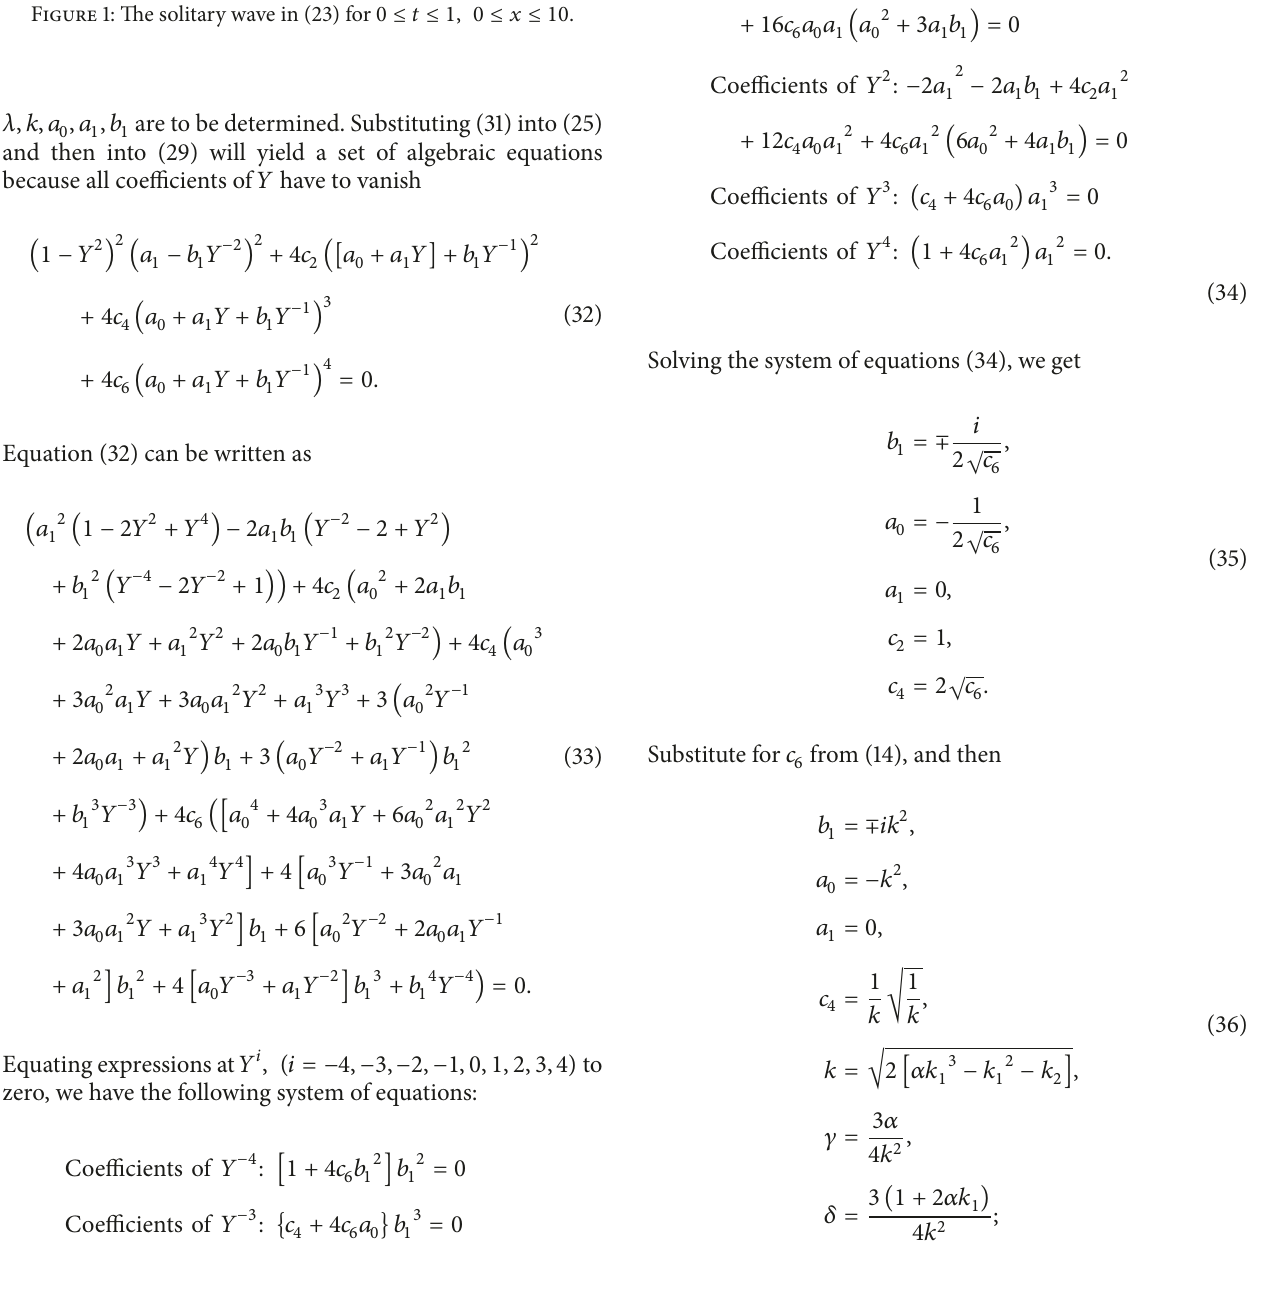
Figure 1: The solitary wave in (23) for 0 ≤ 𝑡 ≤ 1, 0 ≤ 𝑥 ≤ 10 .